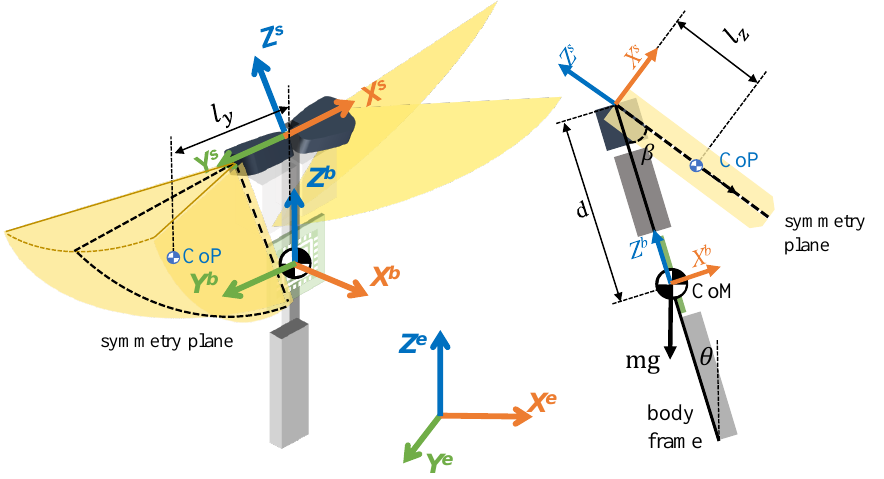
Figure 3. Illustration of model parameters and